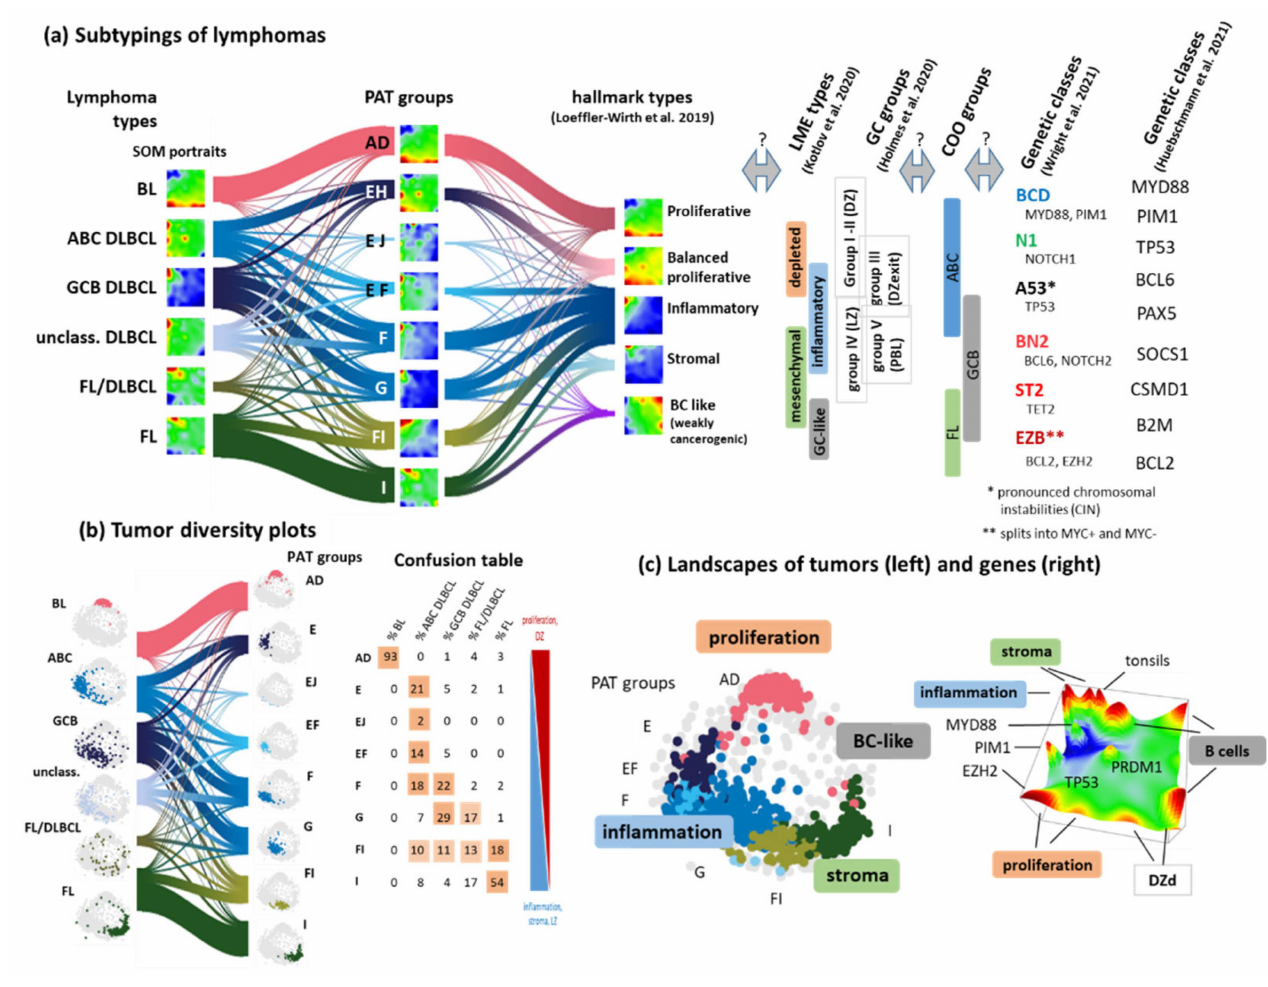
Figure 8. Diversity of lymphoma classification schemes. ( a ) The river plot reflects the mutual fuzziness, especially of DLBCL, between three stratification schemes, namely, lymphoma types, PATs and hallmark types [4]. PAT annotations refer to combinations of expressed spots, e.g., AD stands for the group showing typically joint appearance of spots A and D. The relation to other stratification schemes based on Lymphoma microenvironment (LME) [20], single-cell transcriptomics [24] (see assignments of groups I–V in Figure A6), cell of origin (COO) classes [16] and genetic classifiers using WES [13] or WGS [65] is partly not clear and needs consenting. ( b ) Systematic changing spot patterns in the expression portrait in part ( a ) associate with systematically changing tumor patterns in sample state space (each dot refers to one sample). The confusion table quantifies the mutual overlap and illustrates their systematic shift (colored background). ( c ) Different regions of both, sample (left part) and gene expression (right part) state space assign to different lymphoma types and hallmark characteristics. Position of key mutated genes is